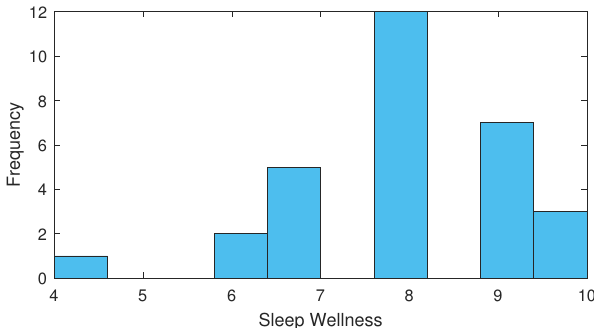
Figure 15. Wellness After Experiment Second